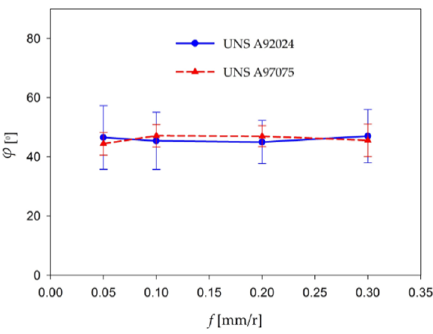
Figure 9. Shear angle ( ϕ ) as a function of feed.